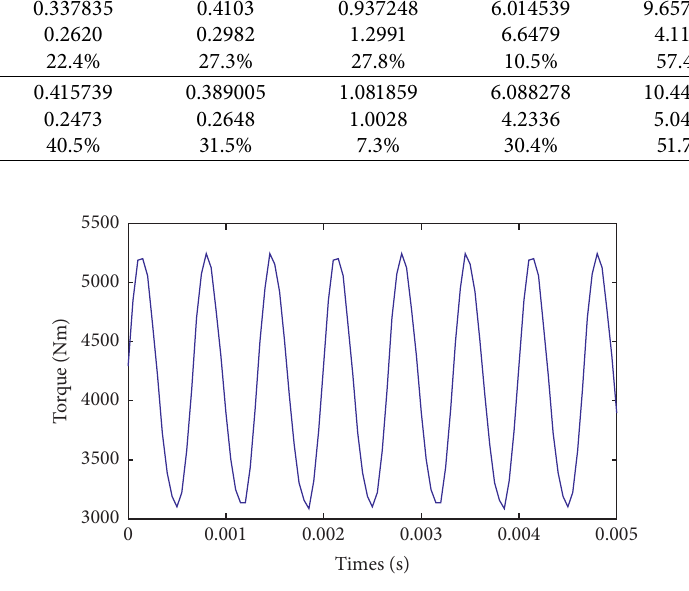
Figure 19: Engine output